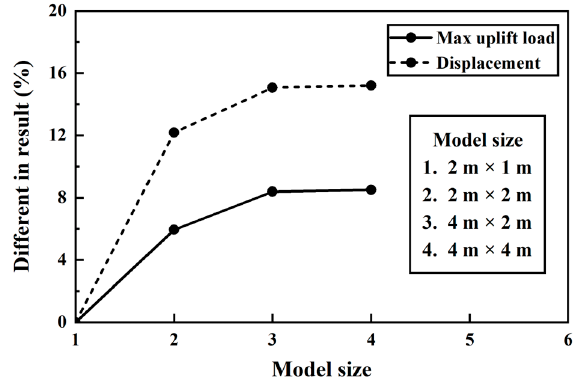
Figure 3. Selection of boundary conditions.